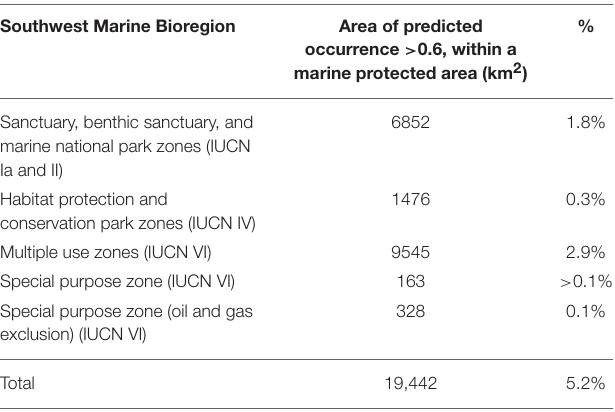
TABLE 3 | South-west marine bioregion protected areas cover 376,137km 2 within the study area. Southwest Marine Bioregion Area of predicted occurrence > 0.6, within